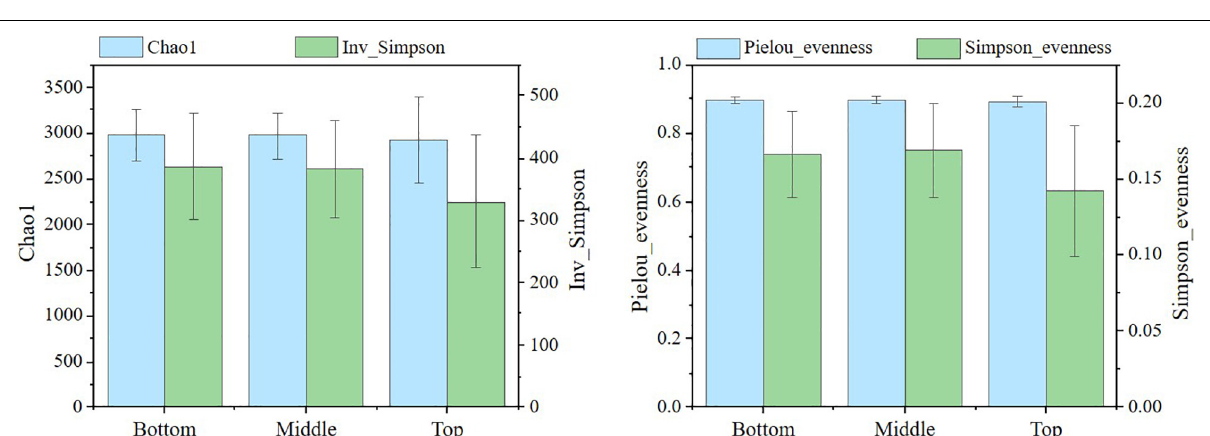
FIGURE 2 | Box-plots of soil physicochemical properties at different locations of the subsidence area. SWC, soil water content; ST, soil temperature; SP, sand proportion; PC, plant cover ratio; AP, available P; NN, nitrate-nitrogen; AN, ammonium nitrogen; AK, available K; SOM, soil organic matter; DHG, dehydrogenase; URA, urease; PRO, protease. The Bottom, Middle, and Top are the positions of the subsidence area.